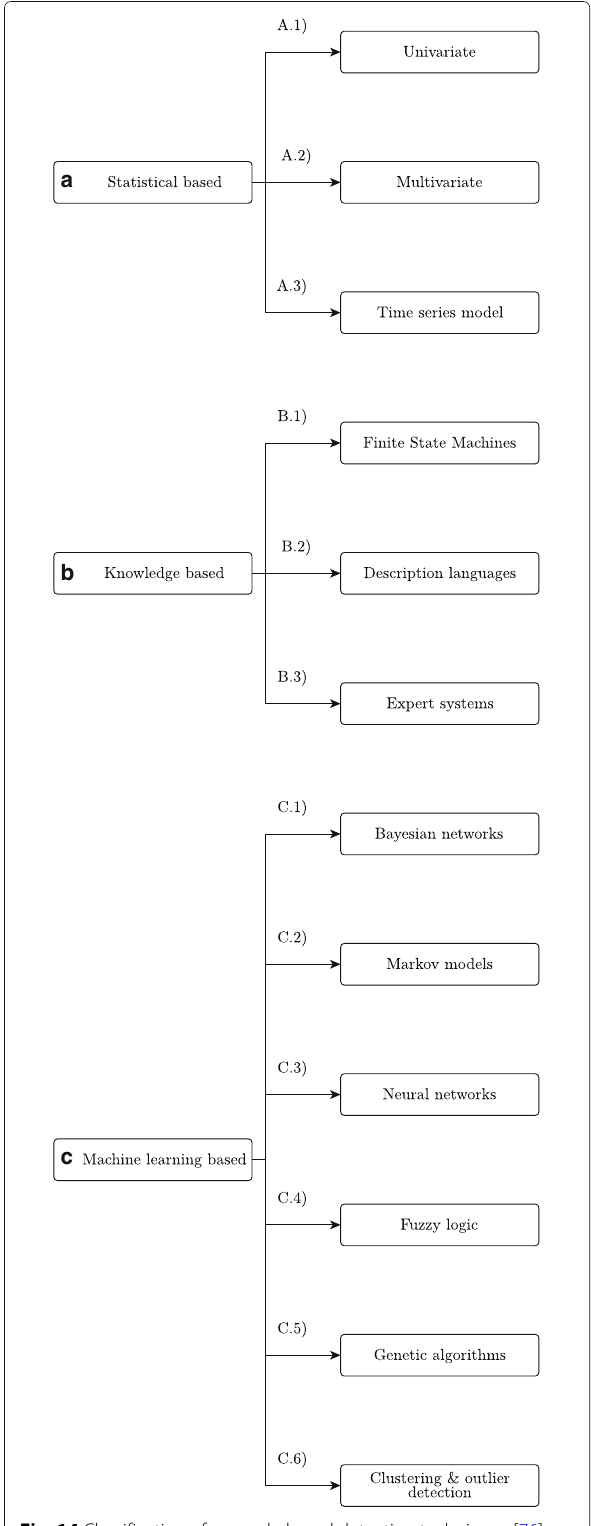
Fig. 14 Classification of anomaly-based detection techniques